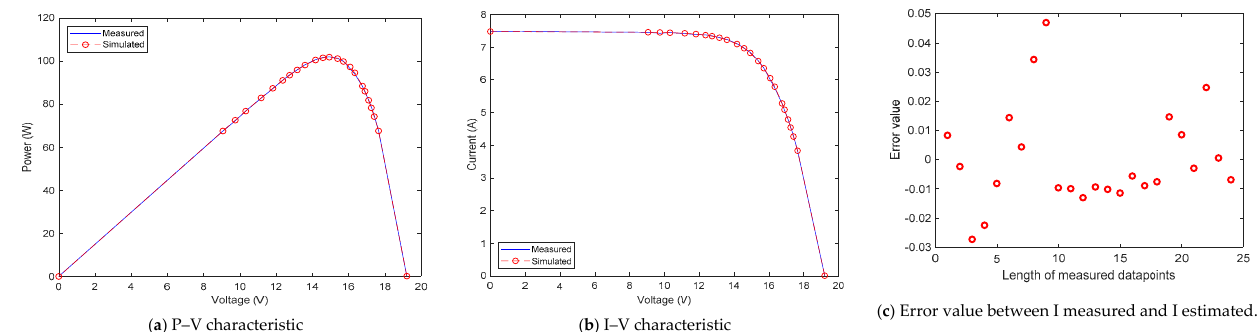
Figure 10. Comparison of the principal characteristics on the STP6 module.